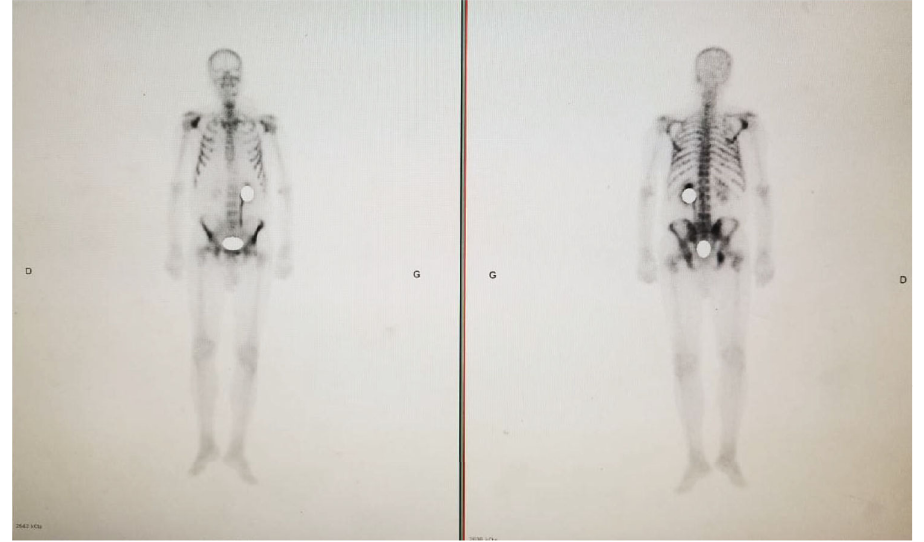
Figure 2: Bone scintigraphy showing several metastatic lesions, including in the lumbar